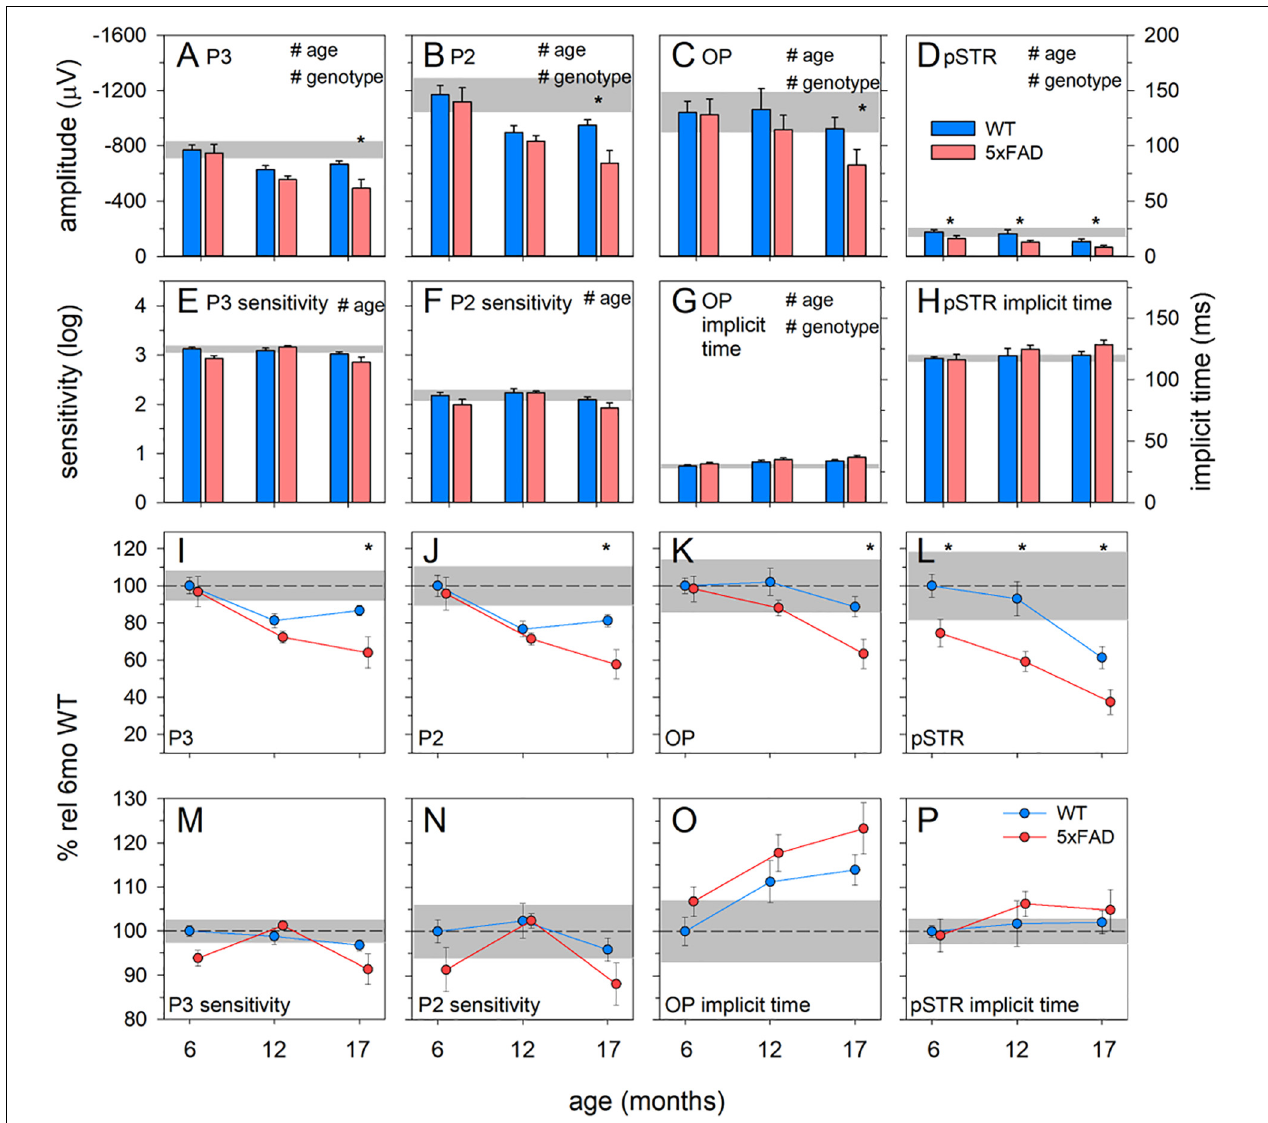
FIGURE 6 | Age-related change in 5xFAD and WT ERG parameters. (A–D) Raw P3, P2, OP, and pSTR, respectively. (E,F) P3 and P2 sensitivity (units, log cd-1.s-1.m 2 ), respectively. (G,H) OP and pSTR implicit time (ms), respectively. (I–P) All ERG parameters normalized to 6-month-old WT to facilitate easier comparison between parameters. The earliest functional change to occur in 5xFAD occurred in the pSTR. An overall trend toward ERG decline with age occurred in all parameters. At 17 months of age, 5xFAD mice showed a significant decline in all ERG parameters. P3, photoreceptoral response; P2, bipolar cell response; OP, oscillatory potentials; pSTR, positive scotopic threshold response; all data shown, mean ± SEM; # p < 0.05 for treatment effect on two-way ANOVA analyses; * p < 0.05 for Bonferroni post hoc